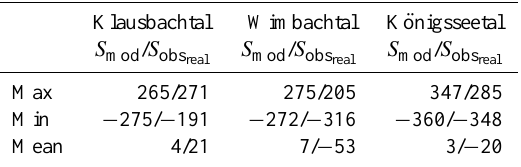
Table 5. Minimum, maximum and mean of monthly modeled ( S mod ) water storage by the hydrological model and observed water storage ( S obs ) in subbasin Klausbachtal, Wimbachtal and K¨onigsseetal (mm).